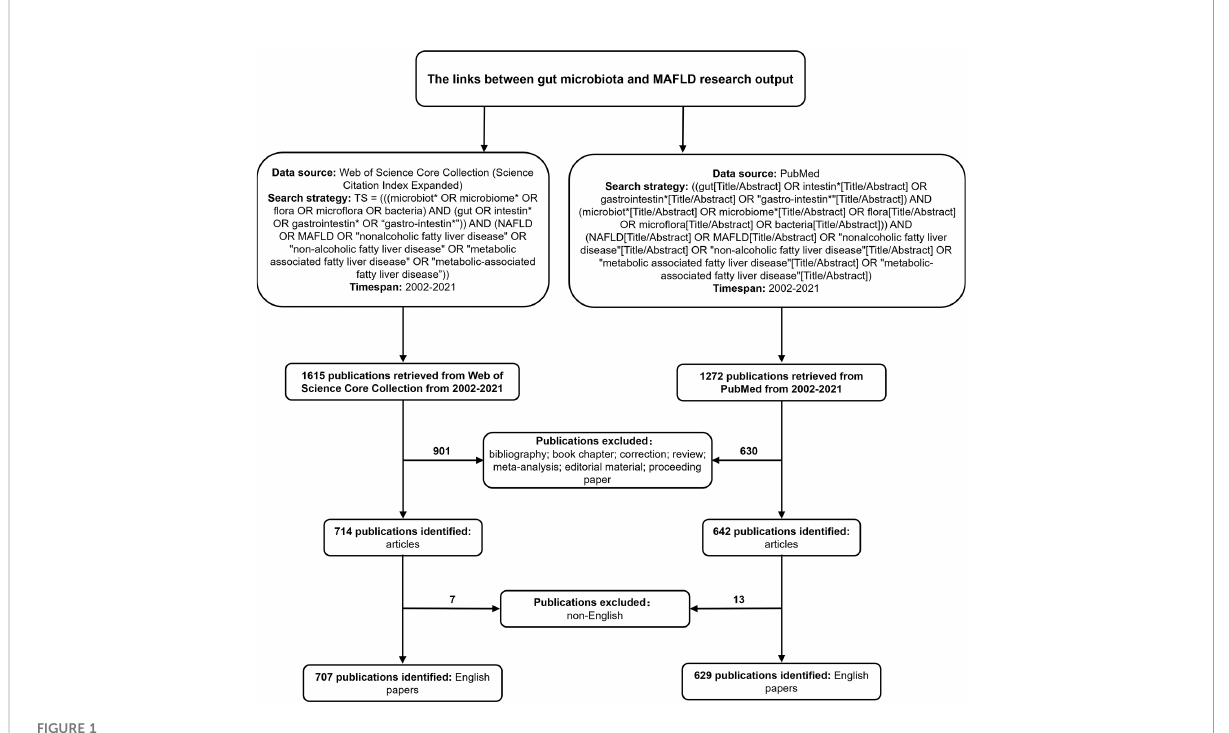
FIGURE 1 Flowchart for including and excluding literature